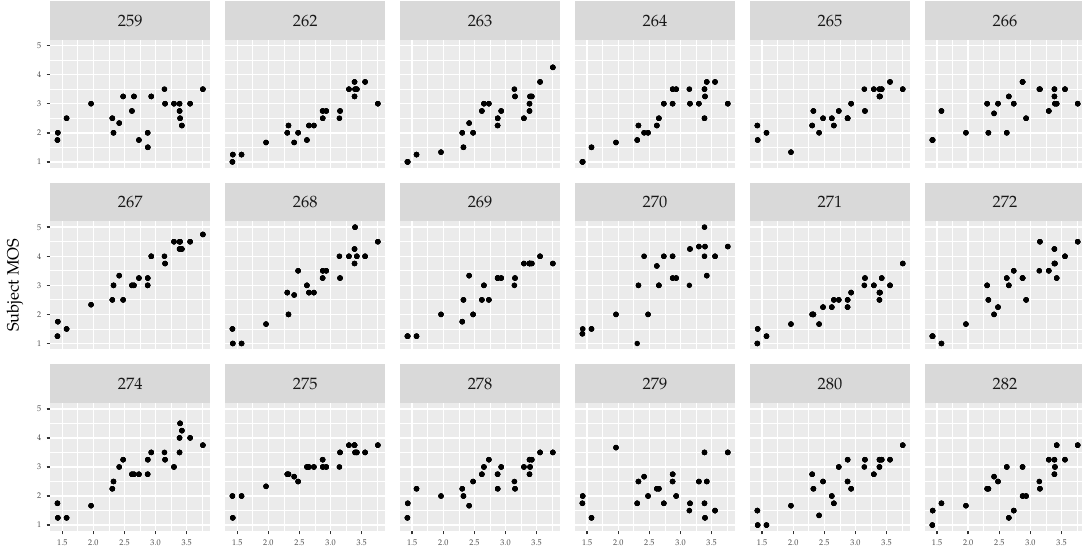
Figure 4. Scatter plots of each subject’s MOS (vertical axis) compared with the MOS of all subjects (horizontal axis). The data comes from the CCRIQ2 data set. We calculate per-subject MOS scores by aggregating individual scores by camera types. In general, opinion scores are consistent and correlated. There are few outliers like subjects number 259 and 279. We do not show a scatter plot for tester 283. This way, it is easier to compare this plot with the one in Figure 5. Due to the same testers being included in both data sets, there is a one-to-one scatter plot correspondence between the two